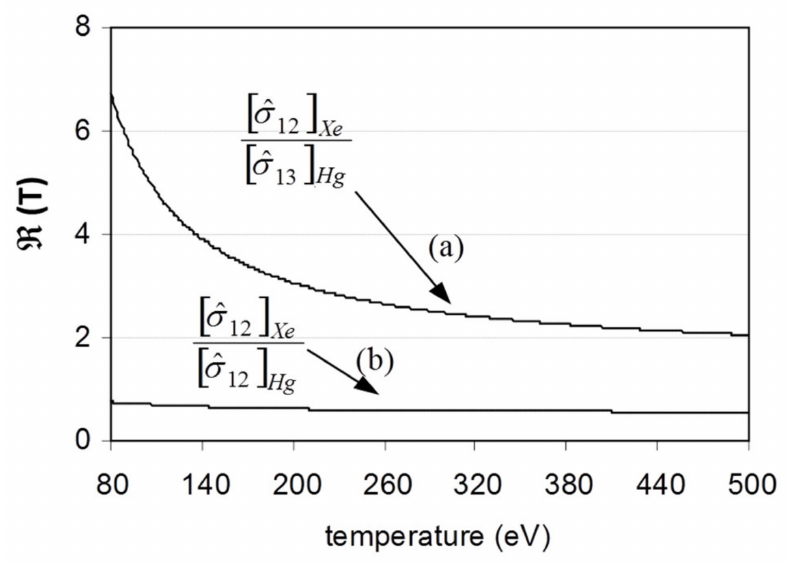
Figure 13. The effective cross-section ratio function for two ionizing